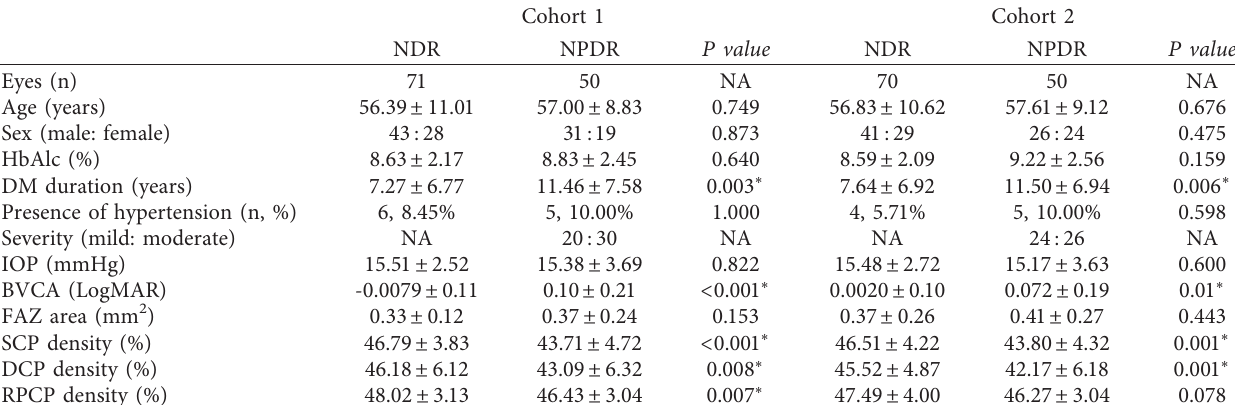
Table 1: General and ocular characteristics of diabetic patients in two cohorts.